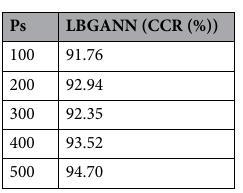
Table 5. Correct classification rate at various Ps